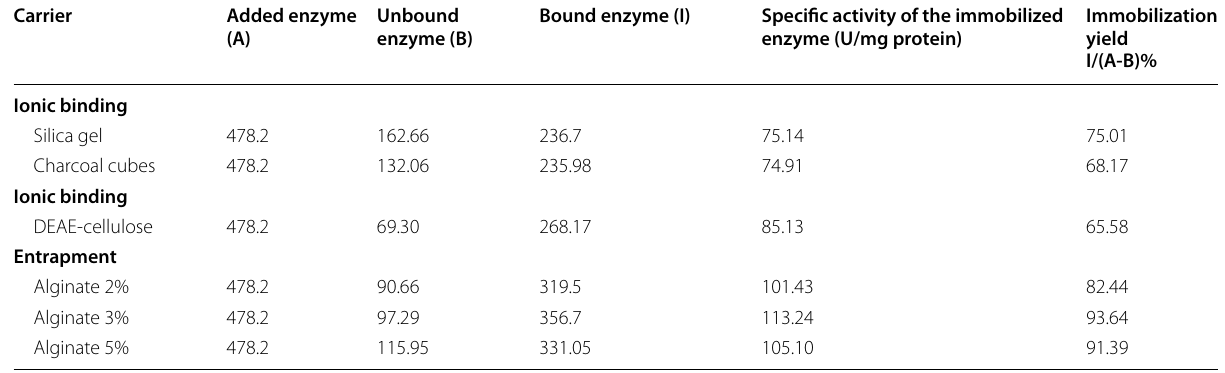
Table 2 Immobilization of partially purified B. subtilis AAK laccase enzyme on different materials